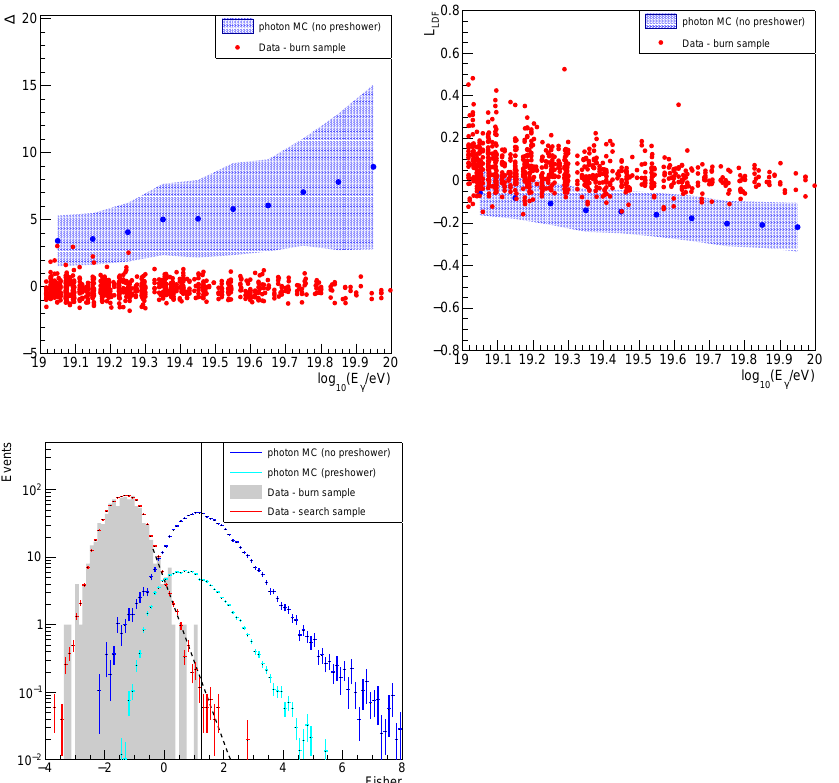
Figure 5. ( Top ) distributions of ∆ ( left ) and L LDF ( right ), i.e., the observables used in the search for photons based on SD-only data, as a function of the photon energy E γ for simulated primary photons (in blue) and a fraction of the data sample (in red) that is used as a burnt sample; the bands represent one standard deviation of the photon distributions. ( Bottom ) distributions of the Fisher discriminant for the burnt sample (grey), the search sample (red) and simulated primary photons (non-preshowering in blue and preshowering in light blue), weighted with an E − 2 spectrum; the search sample and the photon distributions are scaled to have the same integral as the burn sample one; the vertical line indicates the value of the photon-candidate cut; the dashed line shows the result of the fit of an exponential to the 5% of events in the burnt sample with the largest values of the Fisher discriminant. For more details, see